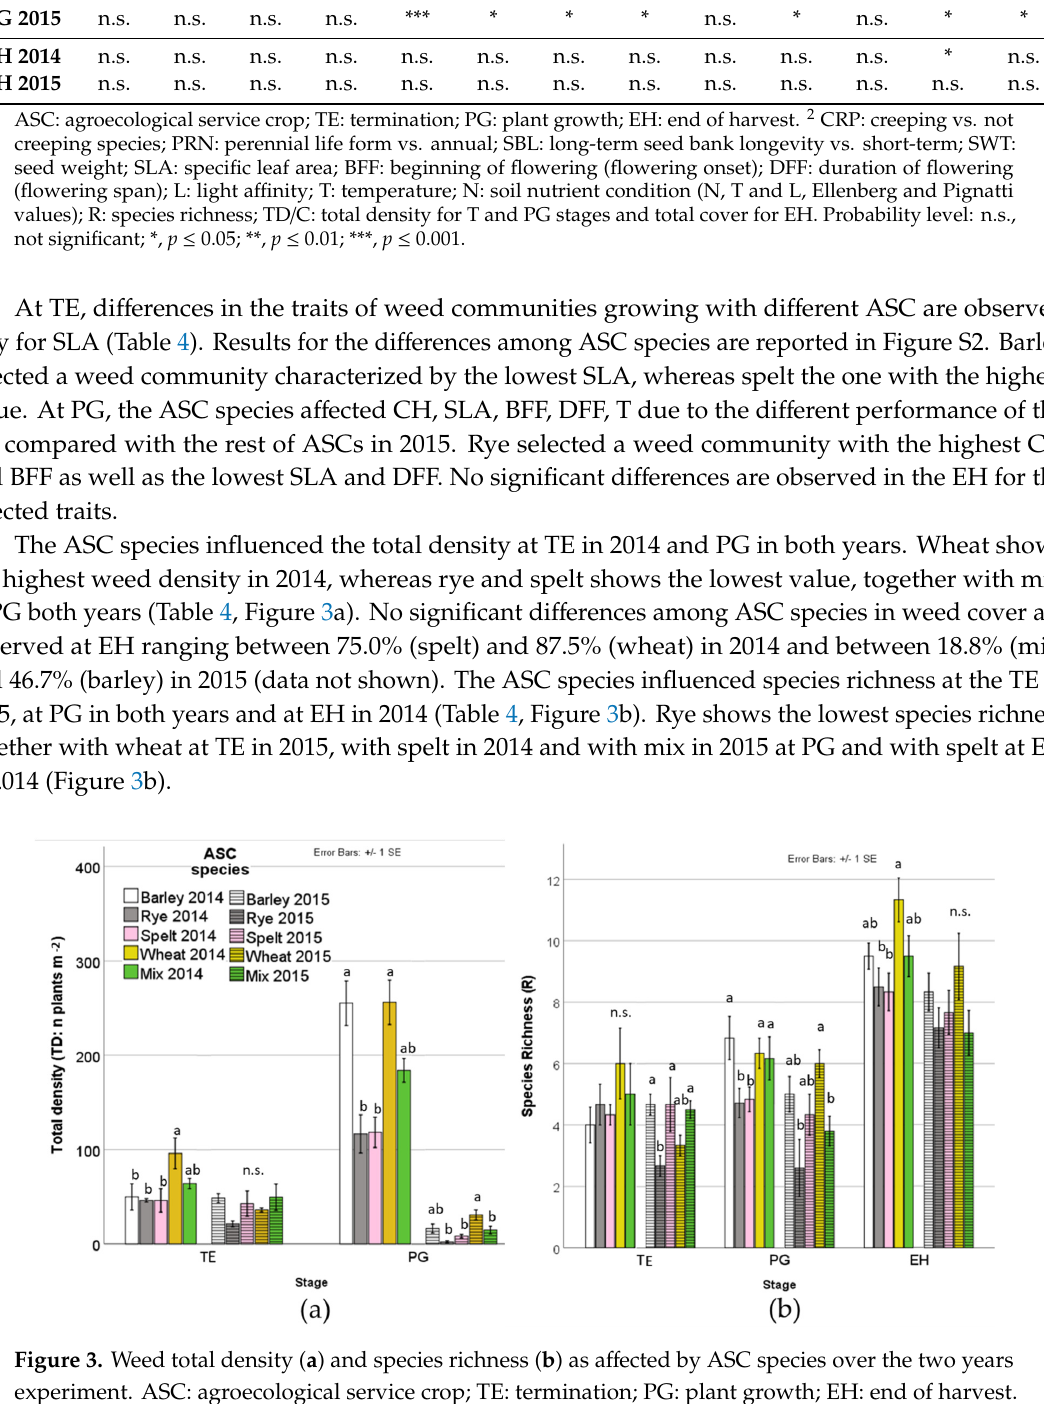
Table 4. Weed traits, Ellenberg ecological indicators, species richness and total density / cover of the weed communities in the two-years experiment as a ff ected by the ASC species. CRP PRN SBL SWT CH